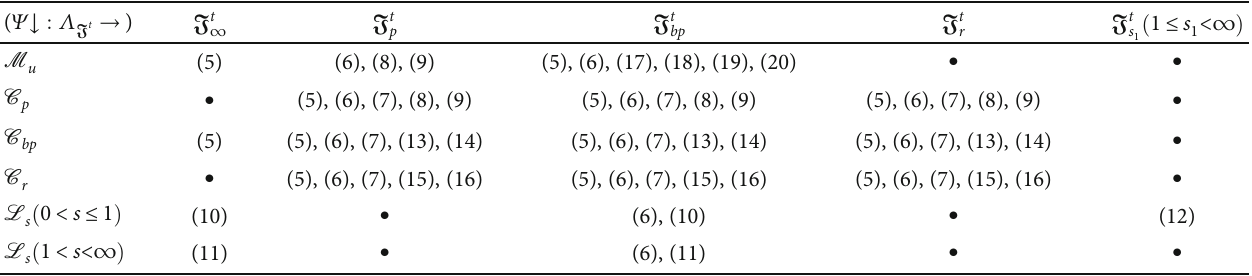
Holds with u mnkl instead of b mnkl .